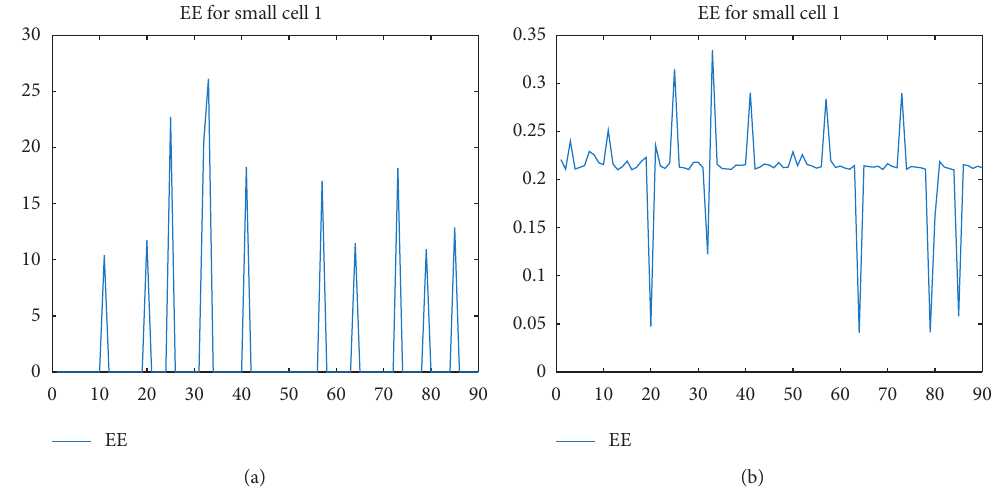
Figure 9: The energy efficiency (a) and SINR (b) of small BS 1 for 90 MUE.